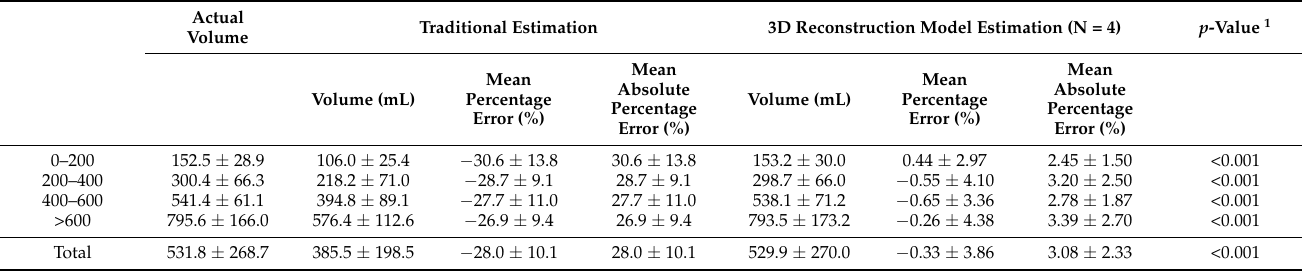
Table 3. Estimated results in different